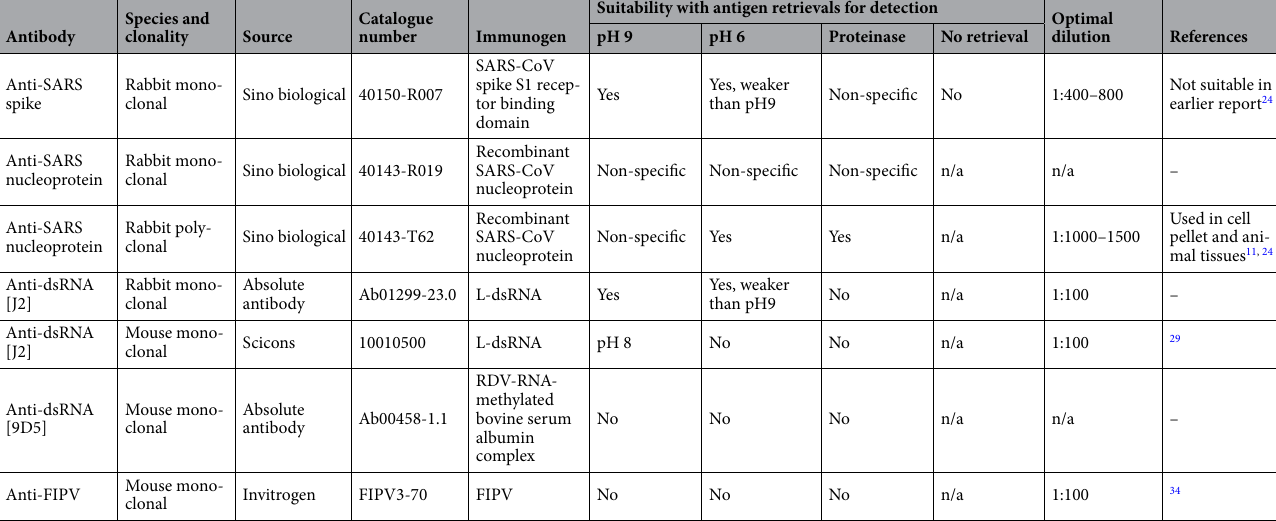
Table 1. Antibodies evaluated for immunoreactivity against formalin-fixed paraffin-embedded SARS coronavirus infected cell pellets by immunohistochemistry. n/a not applicable, dsRNA double stranded RNA, FIPV feline infectious peritonitis